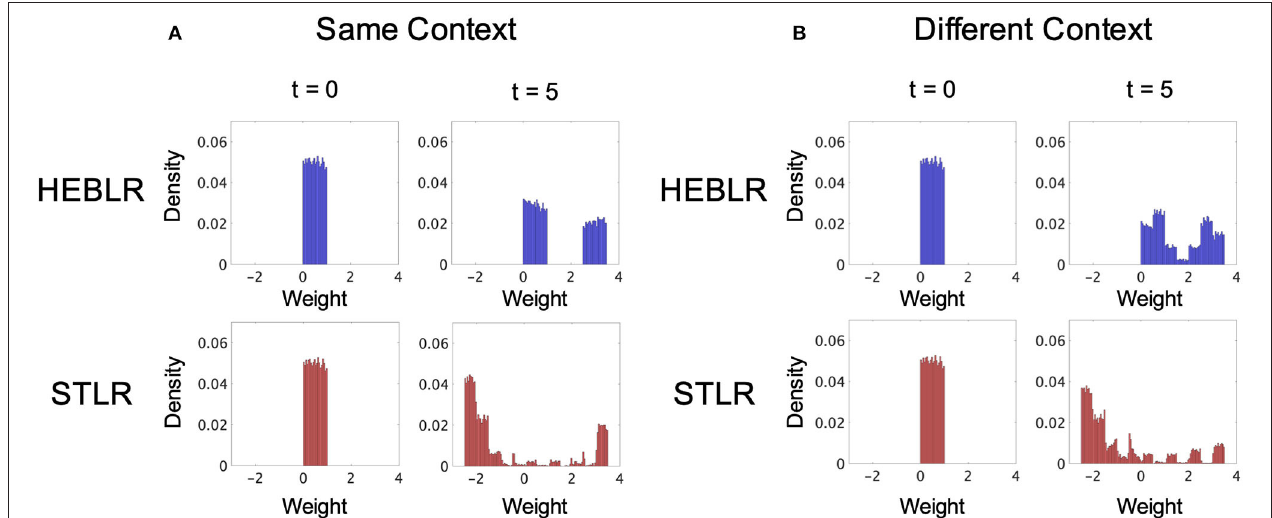
FIGURE 5 | Simulation results of the synaptic weight vector distributions of HEBLR and STLR before training ( t = 0), and after 5 steps ( t = 5). (A) Weight distribution for HEBLR and STLR in the same contextual input. Initial distribution of synaptic weights for HEBLR and STLR (left upper and lower panels). Weight distribution after 5 steps in HEBLR (right upper panel). Weight distribution after 5 steps in STLR (right lower panel). (B) Weight distribution for HEBLR and STLR in different contextual inputs. Initial distribution of synaptic weights for HEBLR and STLR (left upper and lower panels). Weight distribution after 5 steps in HEBLR (right upper panel). Weight distribution after 5 steps in STLR (right lower